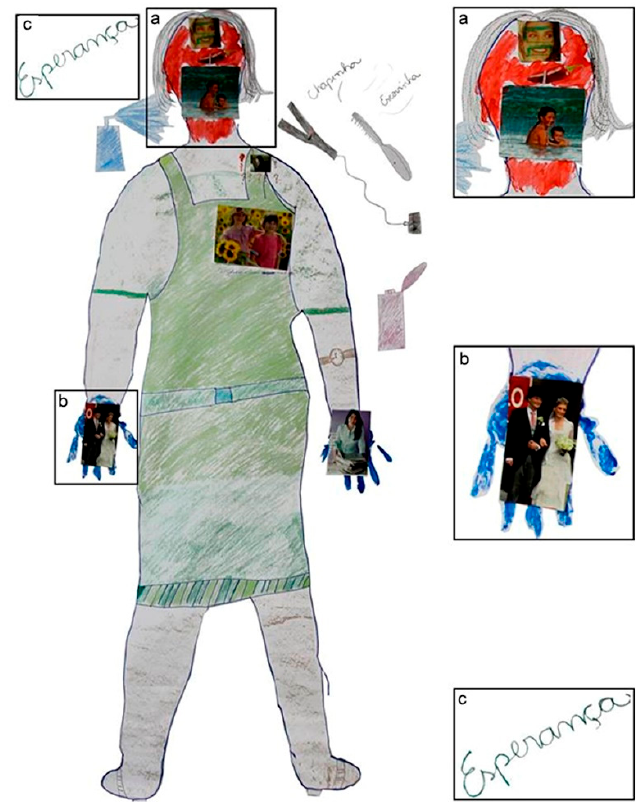
Figure 2. Body map of the participant ID 2. She painted her head in red ( a ), stating it represented “jitters”. In her right hand, she placed a picture of a happy couple to represent her wedding as the most important event of her adult life ( b ); the word “esperança”, “hope” in English, represented her expectations about the future ( c ). Note: The participant used pictures from Brazilian magazines such as “Claudia” and “Veja” to illustrate her body map.